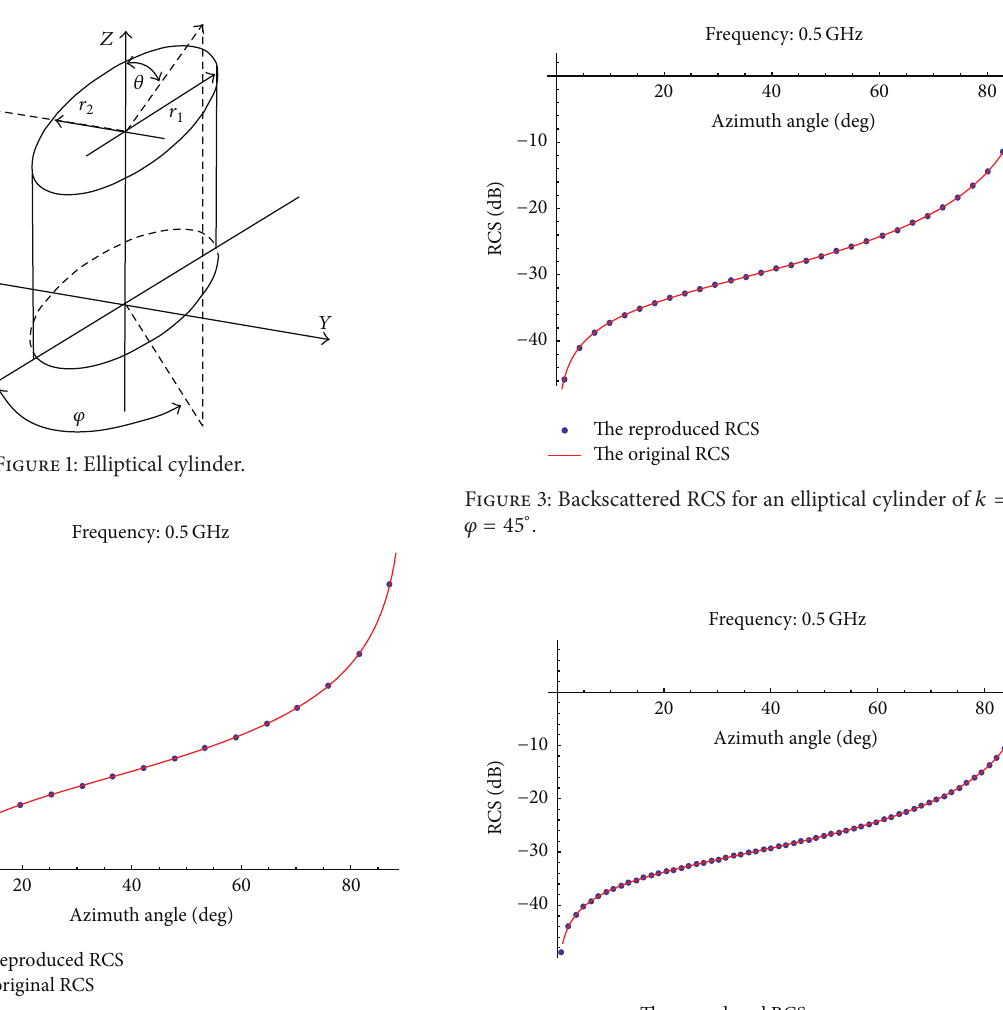
Figure 2: Backscattered RCS for an elliptical cylinder of 𝑘 = 4 and 𝜑 = 45 ∘ .